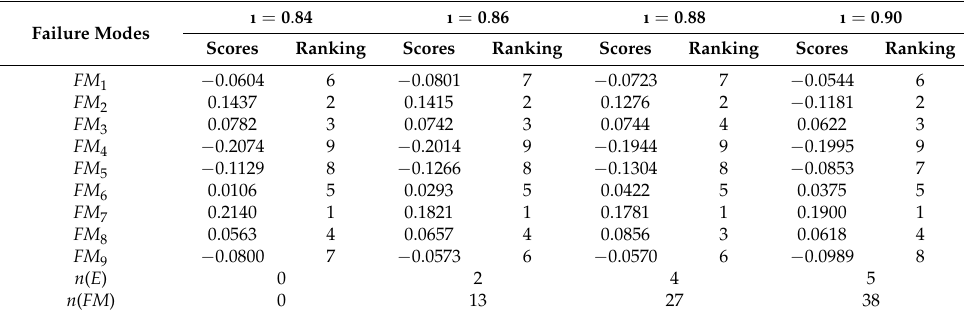
Table 5. Ranking of different threshold values ζ .